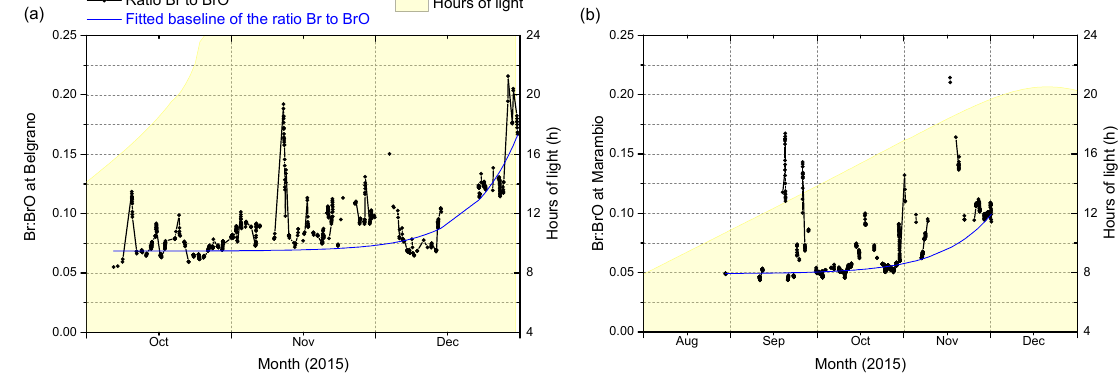
Figure 14. Variability in the ratio of Br to BrO after the polar sunrise at Belgrano (a) and Marambio (b) . The left axes refer to the Br-to-BrO ratio (same scales on both plots) with the estimated ratios shown in black and the fitted baseline in blue. The right axes on both plots refer to the hours of light at each station. The horizontal scales indicate the time period. Note that only data observed under low wind conditions and with a SZA<75 ◦ are